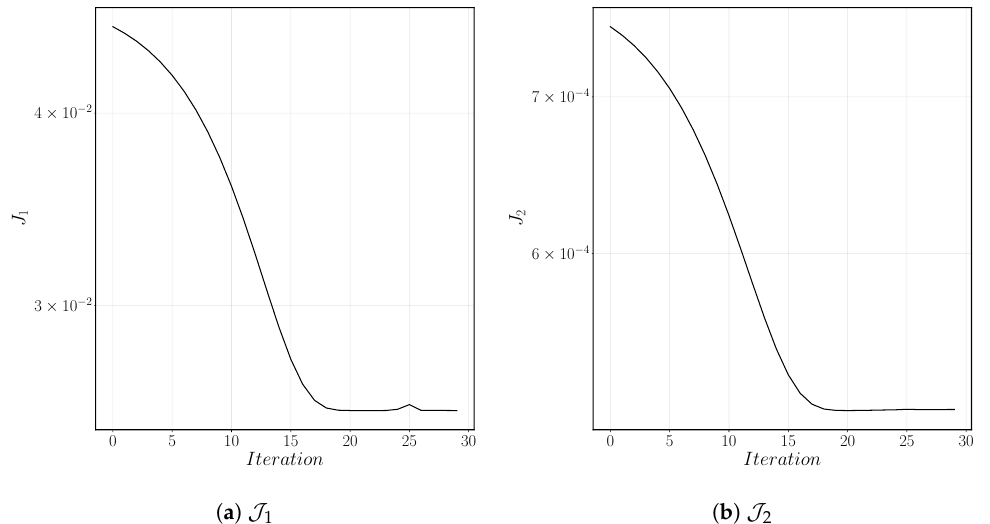
Figure 7. Evolution of the two terms of the cost functional as a function of the descent iteration.